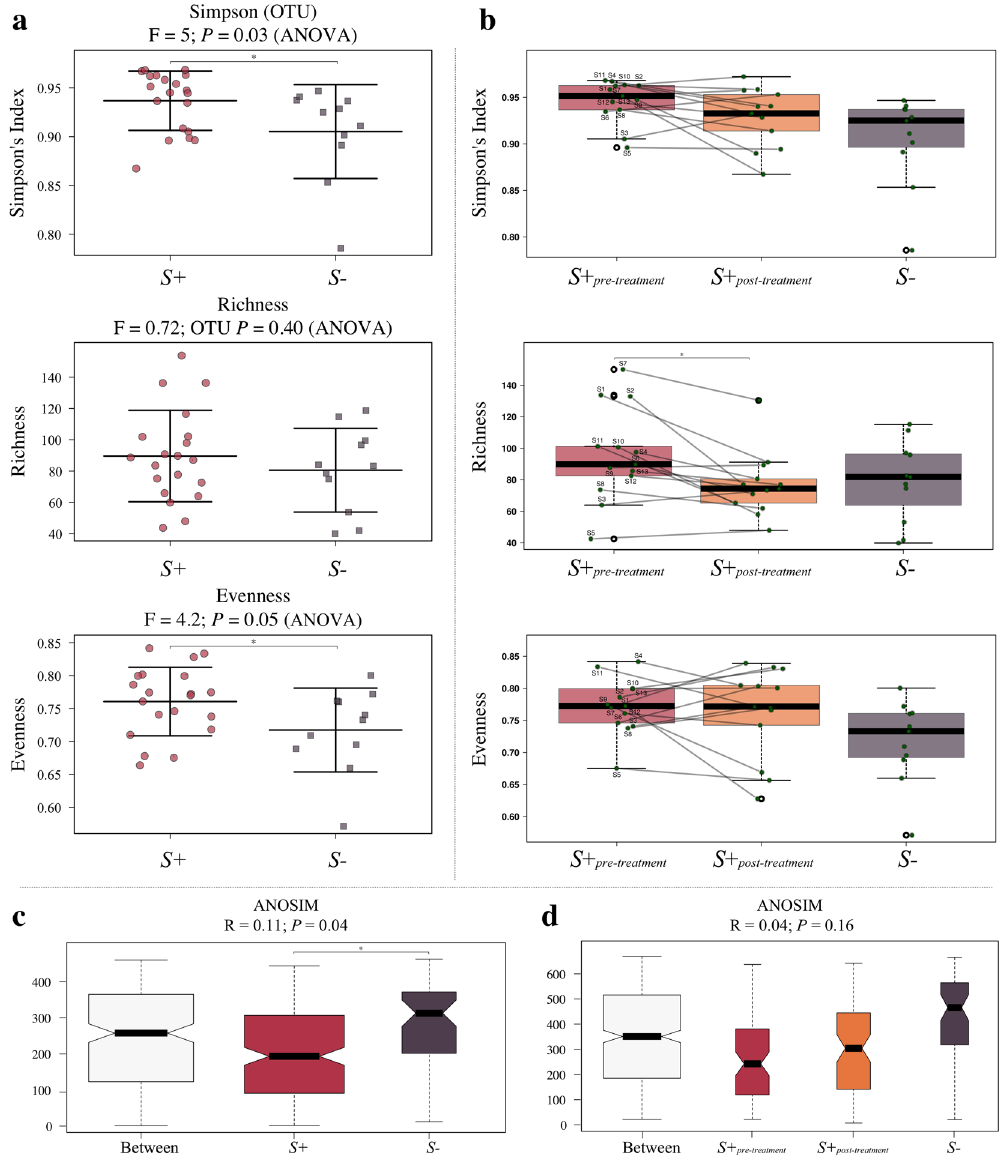
Figure 3. The faecal microbiome of Strongyloides stercoralis -infected subjects is characterised by increased alpha diversity and decreased beta diversity, respectively, when compared to that of uninfected controls. ( a ) Differences in overall microbial Simpson (alpha) diversity, and corresponding richness and evenness, between the faecal microbial profiles of S . stercoralis -infected and uninfected subjects ( S + and S − , respectively), and ( b ) between the faecal microbial profiles of the subset of S + subjects that had received anthelmintic treatment, both prior to ( S + pre-treatment ) and 6 months post-ivermectin administration ( S + post-treatment ), and of S − subjects. ( c ) Differences in microbial beta diversity between S + and S − samples, as well as ( d ) between samples from S + pre- + − . The bold and black horizontal lines in the boxplots refer to the respective mean treatment , S post-treatment and S (i.e. Simpson’s Index, richness, and evenness) associated with the corresponding group, with top and bottom whiskers representing the standard deviation. Points connected by lines in ( b ) refer to samples collected from the same study participant pre- and post-anthelmintic treatment. Significant differences between study groups are marked by an asterisk ( *